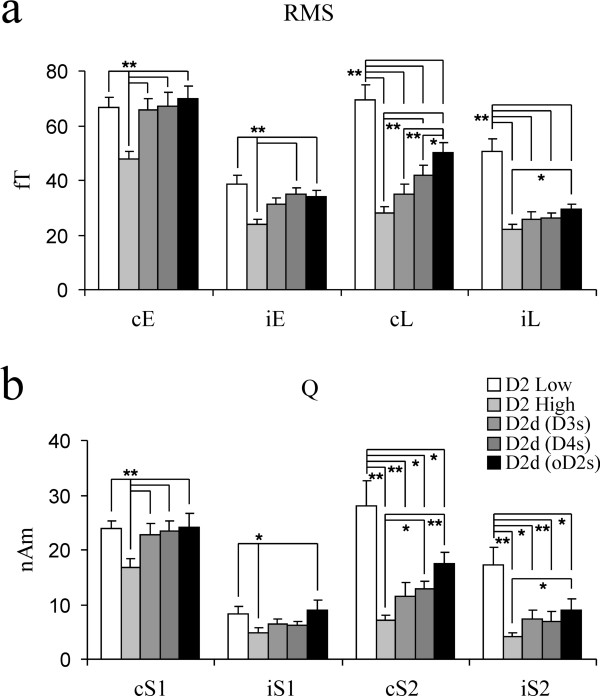
Spatial integration. Grand average of the peak sensor amplitude (a: RMS) and dipole moment (b: Q) values for early (anterior parietal area) and late (S2/PV) responses under different experimental conditions are compared. Asterisks indicate that the responses are significantly (*: p < 0.05; **: p < 0.01) different from others that are linked to it by the lines, using the Bonferroni post-hoc test. c, i, E and L stand for contralateral, ipsilateral, early and later response, respectively. S1 and S2 stand for anterior parietal areas and S2/PV respectively. D2 Low: D2 stimulation alone at low rate (condition 1 in Figure 6; mean ISI: 2s); D2 High: D2 stimulation alone at high rate (condition 2 in Figure 6; ISI: 0.33s); D2d (D3s): D2 deviant plus D3 standard stimuli (condition 3 in Figure 6; ISI: 0.33s); D2d (D4s): D2 deviant plus D4 standard stimuli (condition 4 in Figure 6; ISI: 0.33s); D2d (oD2s): D2 deviant plus opposite D2 standard stimuli (condition 5 in Figure 6; ISI: 0.33s).